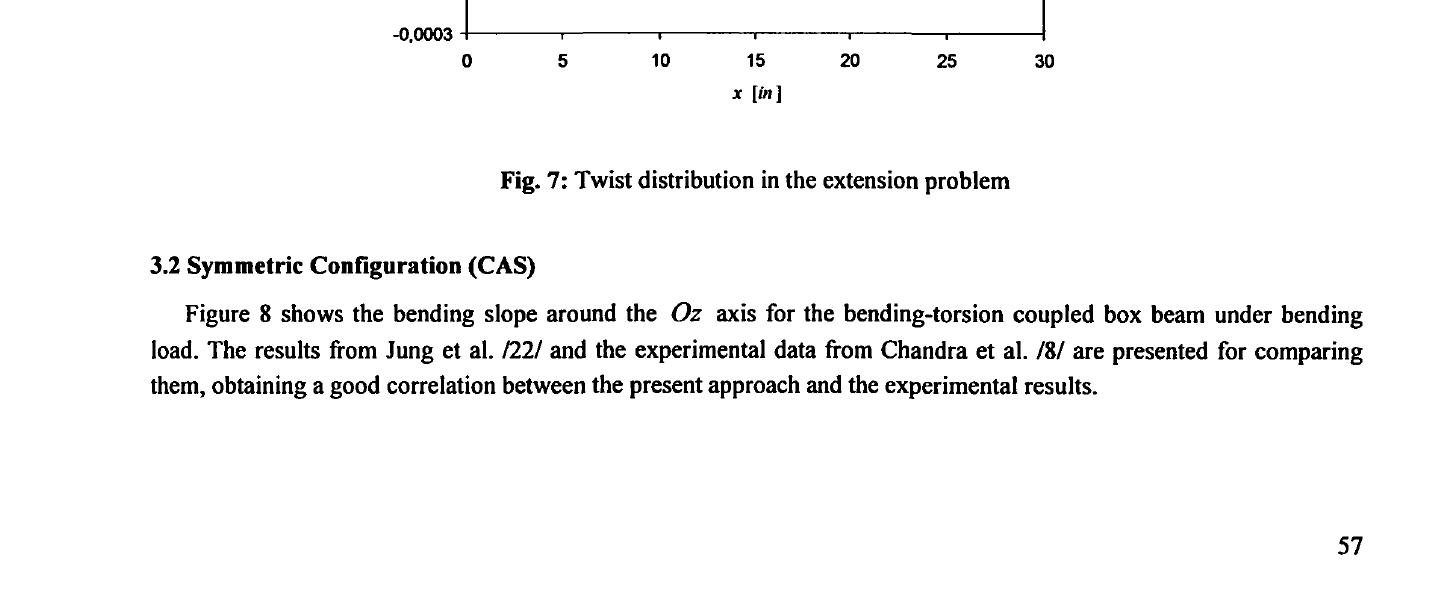
Fig. 7: Twist distribution in the extension